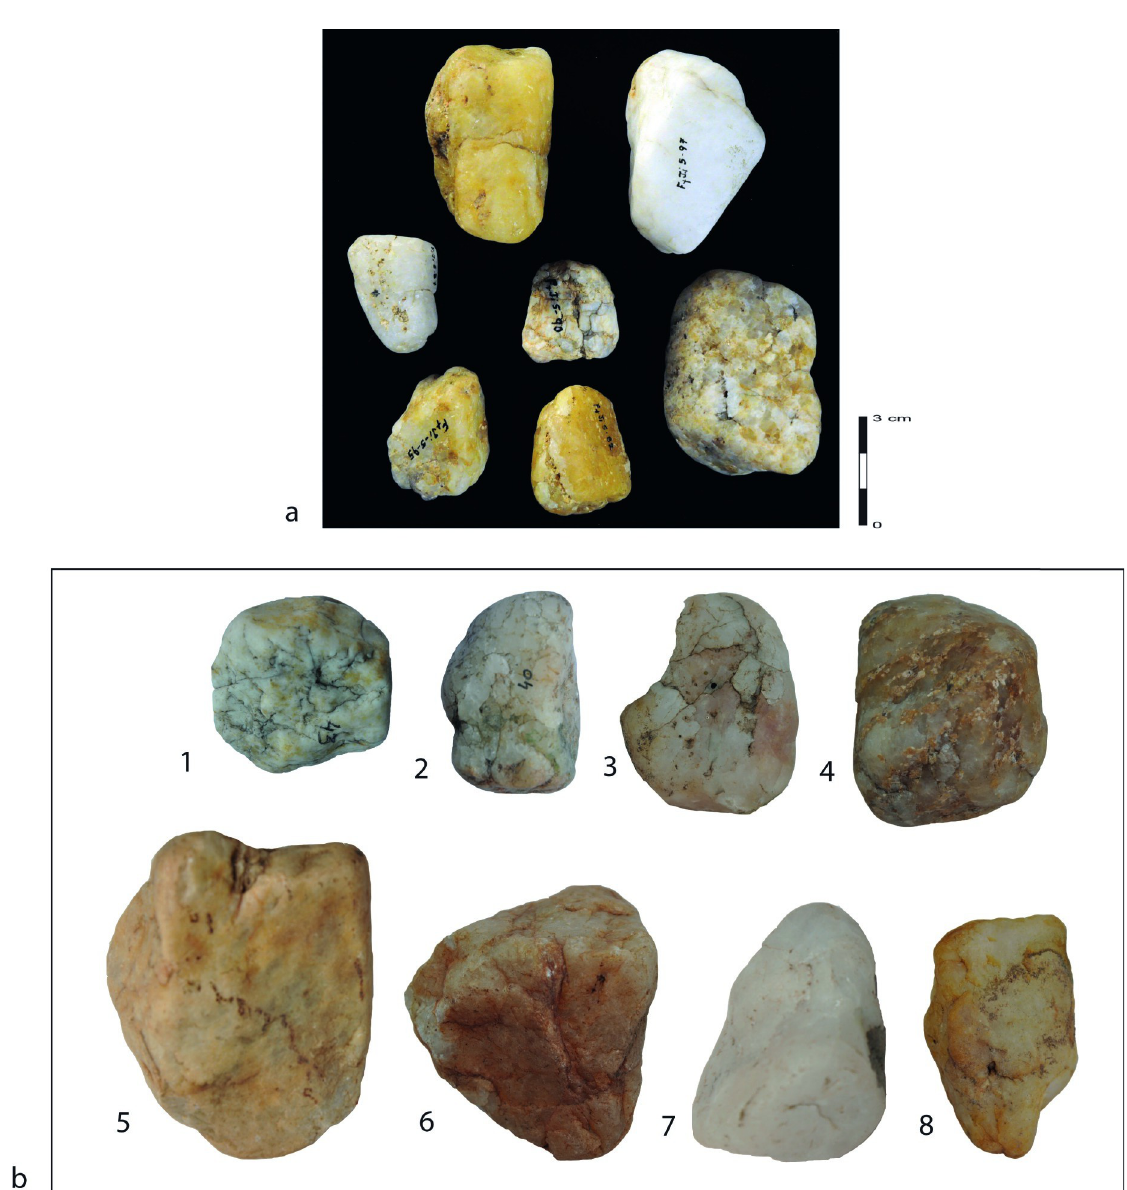
Fig 1. a. Selection of archaeological quartz pebbles from FtJi5 site complex [17, 20]. This site complex is found in a conglomerate at the bottom of Member F and provides a unique abundance of unmodified quartz pebbles in archaeological context at the Shungura formation scale; b. experimental quartz pebbles from the Lower Omo Valley. 1 to 4: medium to low quality quartz pebbles due to internal cracks (1), coarse grain structure (2 and 3), or heterogeneous matrix (4), 5 to 8: good quality quartz pebbles. NB. Scale identical to a .